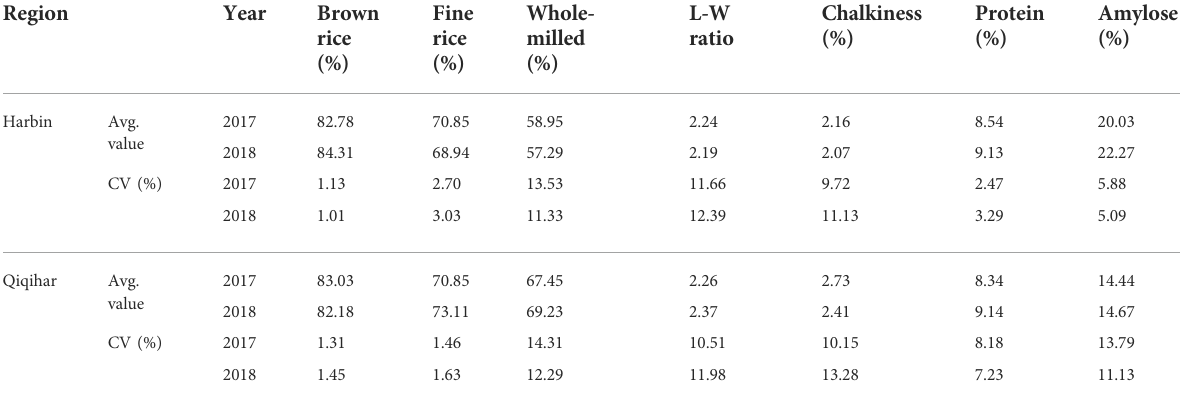
TABLE 8 Variations in rice quality attributes among all four cultivars under the climatic conditions in Harbin and Qiqihar, 2017 and 2018. Region Fine